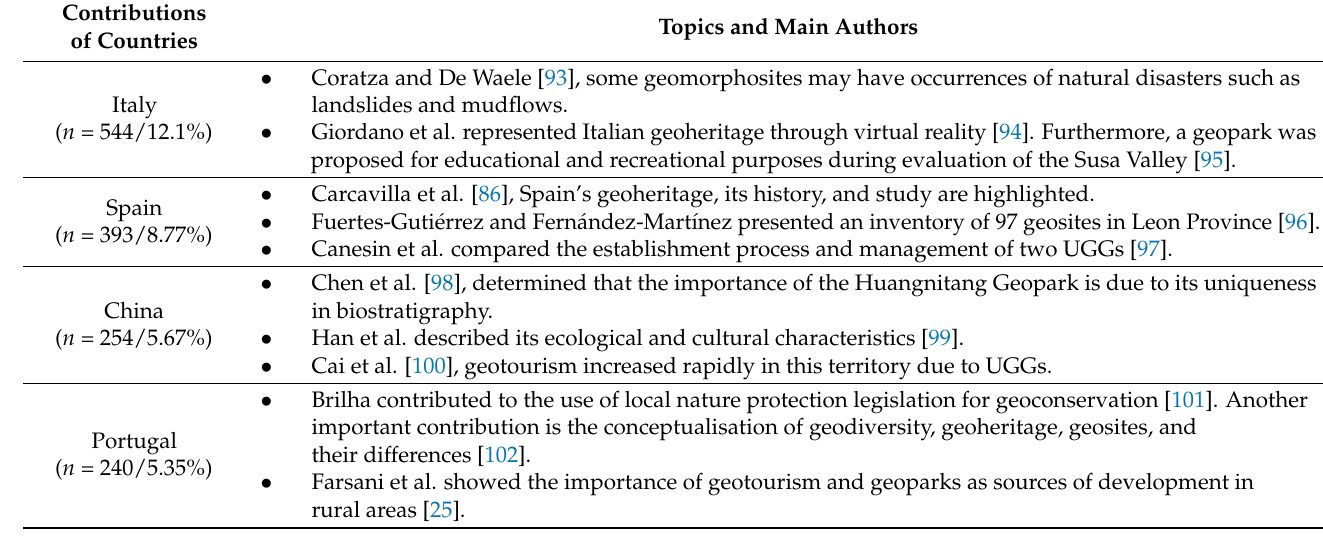
Table 1. Contribution of countries and main